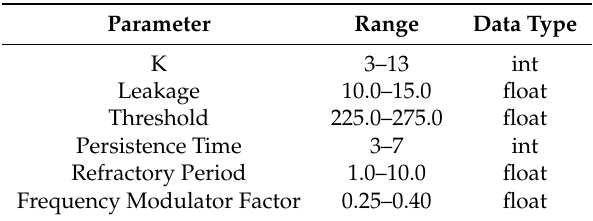
Table 1. Chromosome parameters with their variation range.